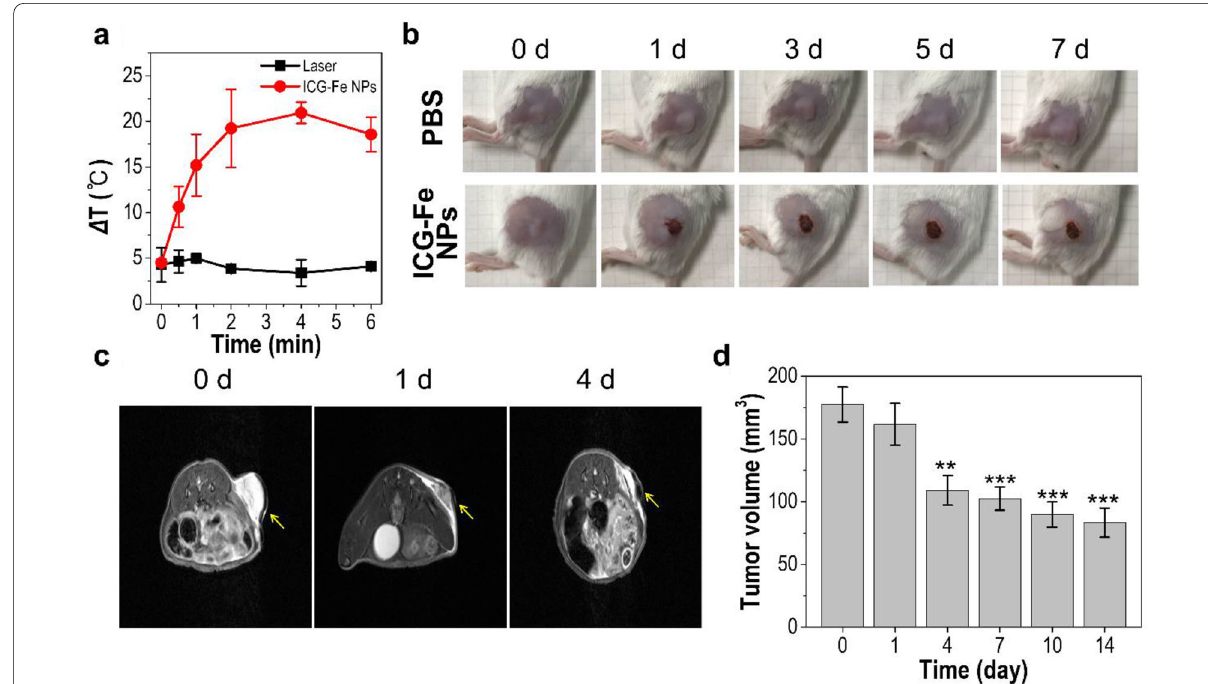
Fig. 7 In vivo PTT in a HT‑29 tumor‑bearing mouse model. a Temperature changes at the tumor during treatment with laser alone or ICG‑Fe NPs + laser. b Photographs of HT‑29 tumor‑bearing mice treated with PBS or ICG‑Fe NPs laser. c Representative axial in vivo T 2 ‑weighted MRI images of + mice treated with ICG‑Fe NPs laser. d Tumor volume changes estimated via MRI for 14 days post‑treatment. Laser irradiation (785 nm, 1.5 W) was + performed for 10 min 24 h after intravenous injection. The yellow arrow indicates a tumor region. Data are means SD based on 3 mice per group. ± ** P < 0.01; *** P < 0.001